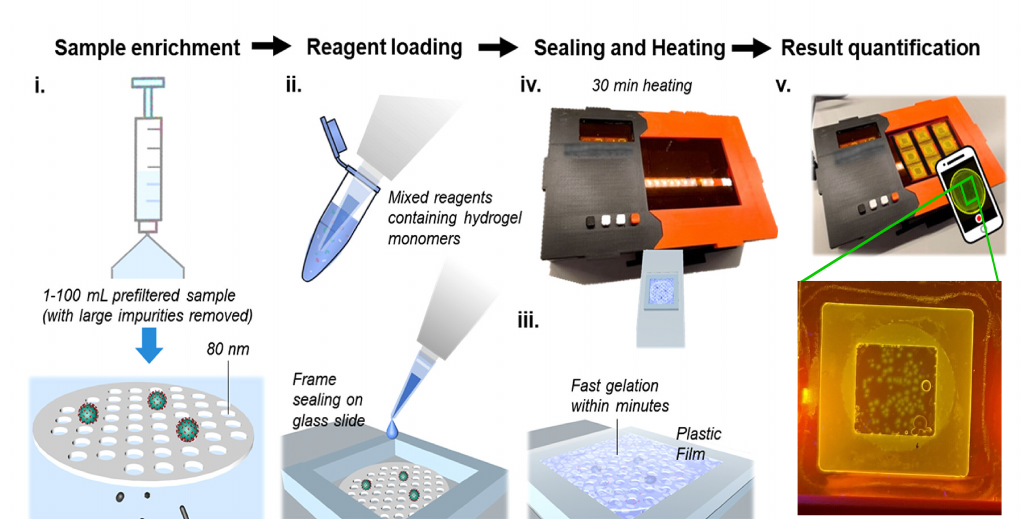
Figure 1. Data retriving process from the mgLAMP ( i ) Filtration. ( ii ) Reagent loading. ( iii ) Sealing. ( iv ) Incubation. ( v ) Imaging.